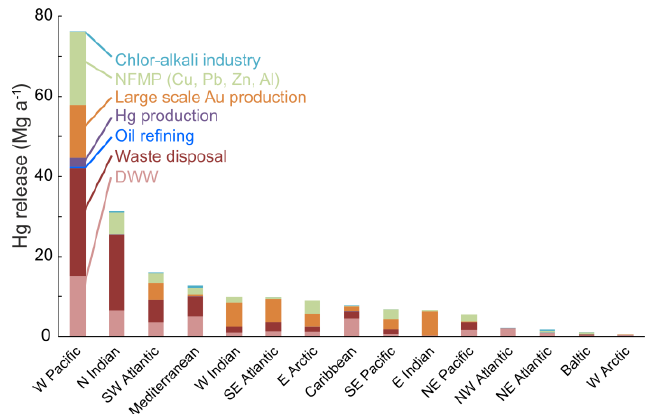
Figure 2. Release estimates of mercury (Hg) from various point source categories and by drainage basins in 2010 (NFMP: Non-ferrous metal production; DWW: Domestic wastewater).